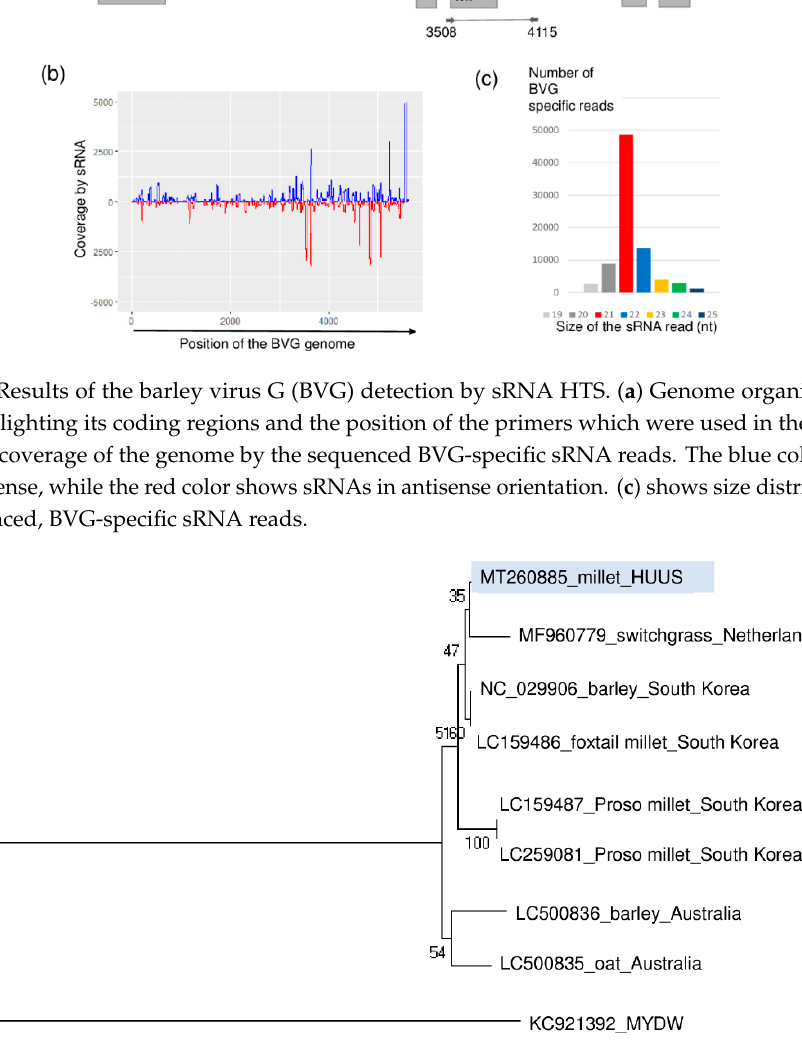
Figure 6. Phylogenetical analysis of the barley virus G (BVG) strain originated from US. (MYDW—Maize yellow dwarf virus).